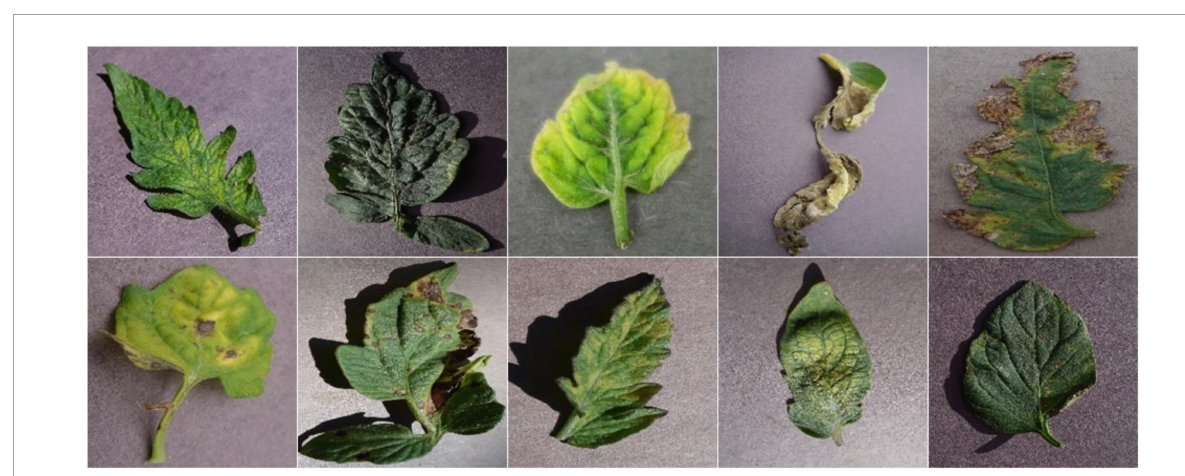
FIGURE5 An example of tomato plant leaves samples from the PlantVillage dataset.